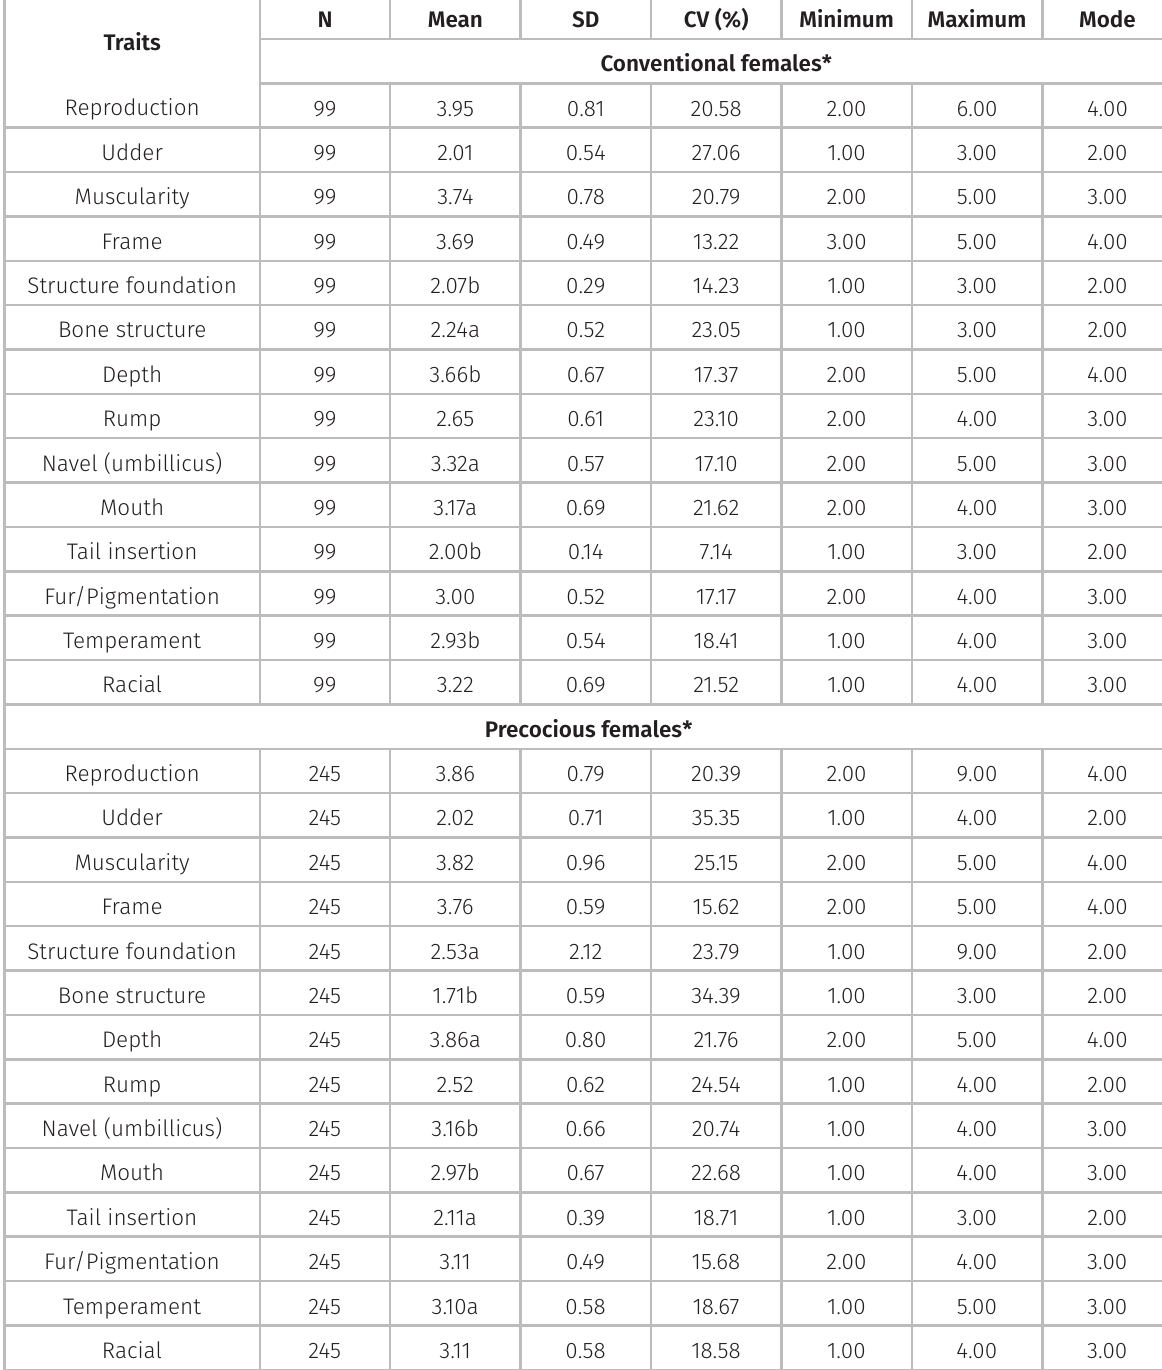
Table III. Descriptive statistics and variance analysis results of t-test for visual scores traits for conventional and precocious heifers. N Mean SD CV (%) Minimum Maximum Mode Traits Conventional